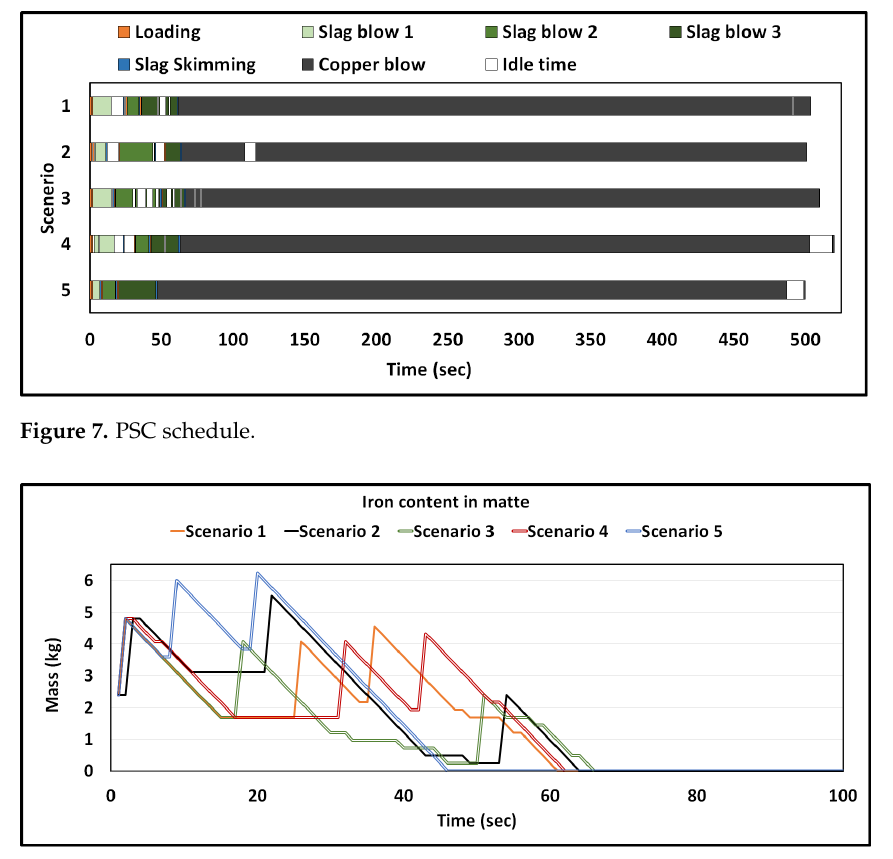
Figure 8. Iron content in